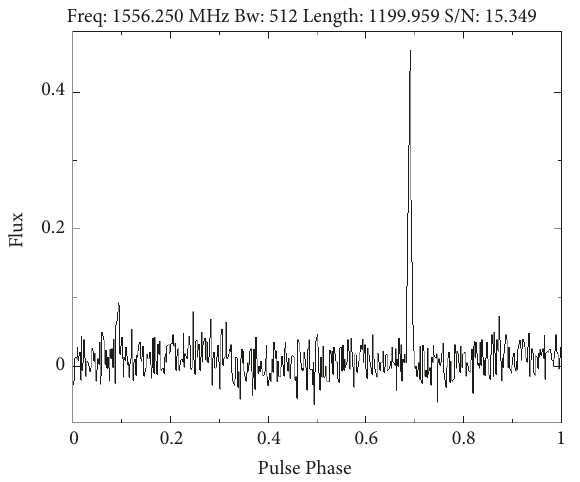
Figure 5: Pulse profile of PSR J0534+2200 (file name: x170814 074136.rf, the flux is not